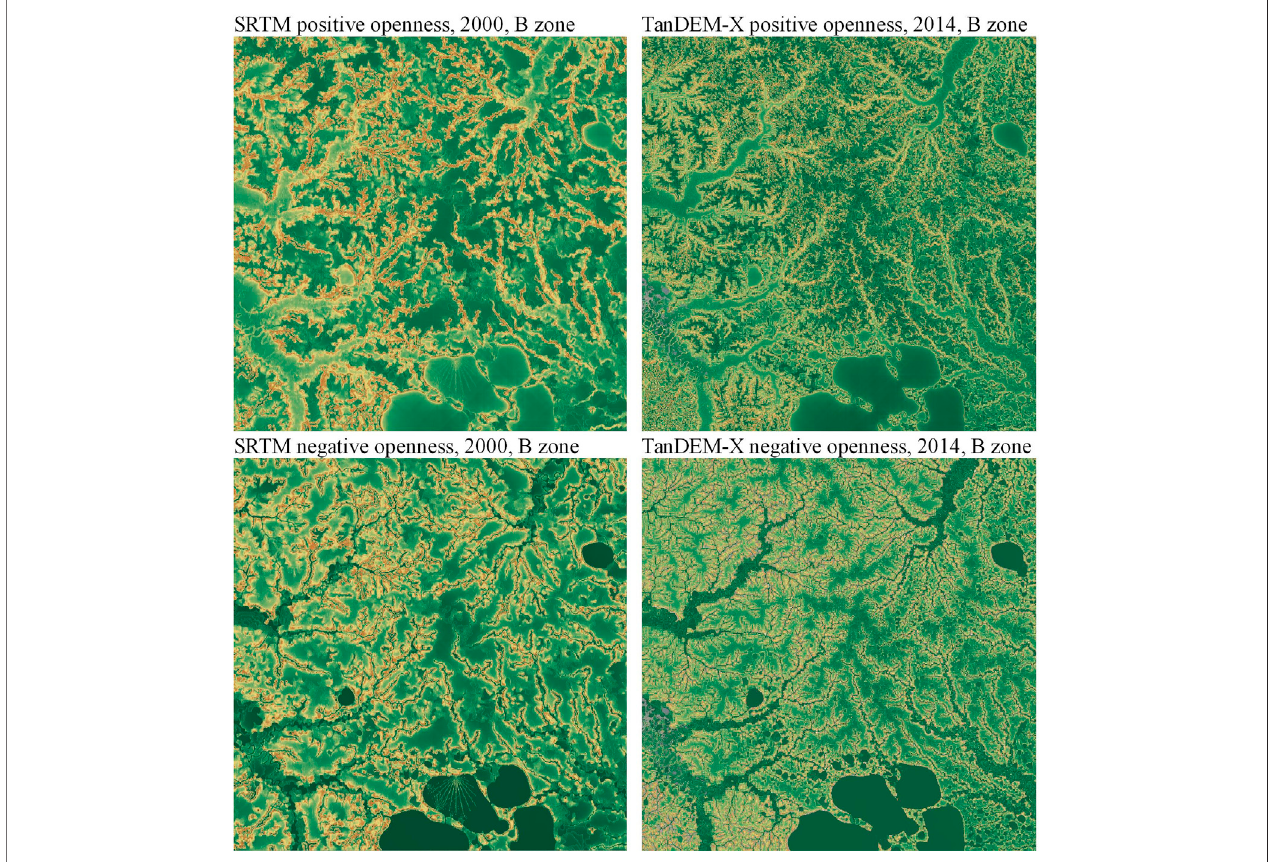
FIGURE 9 | SRTM and TanDEM-X DEMs openness metric showing surface relief changes over 14 years for B zone. Positive openness highlights the drainage network changes. Negative openness highlights the shape of lakes and formation of new lakes.